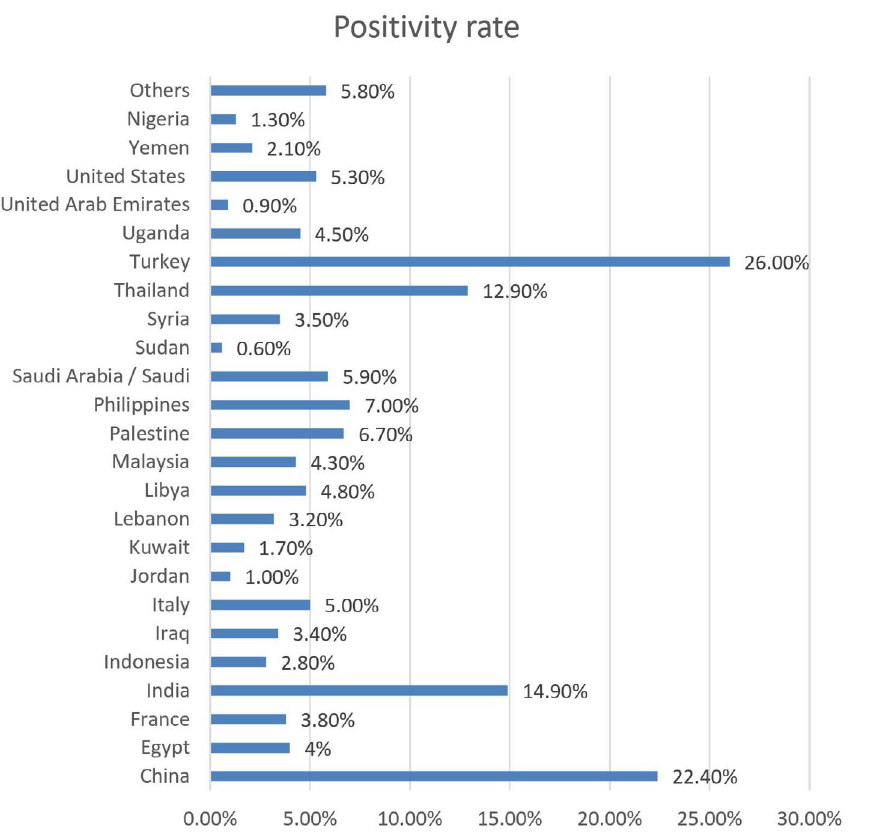
Fig. 4. COVID-19 PCR positivity rates among different